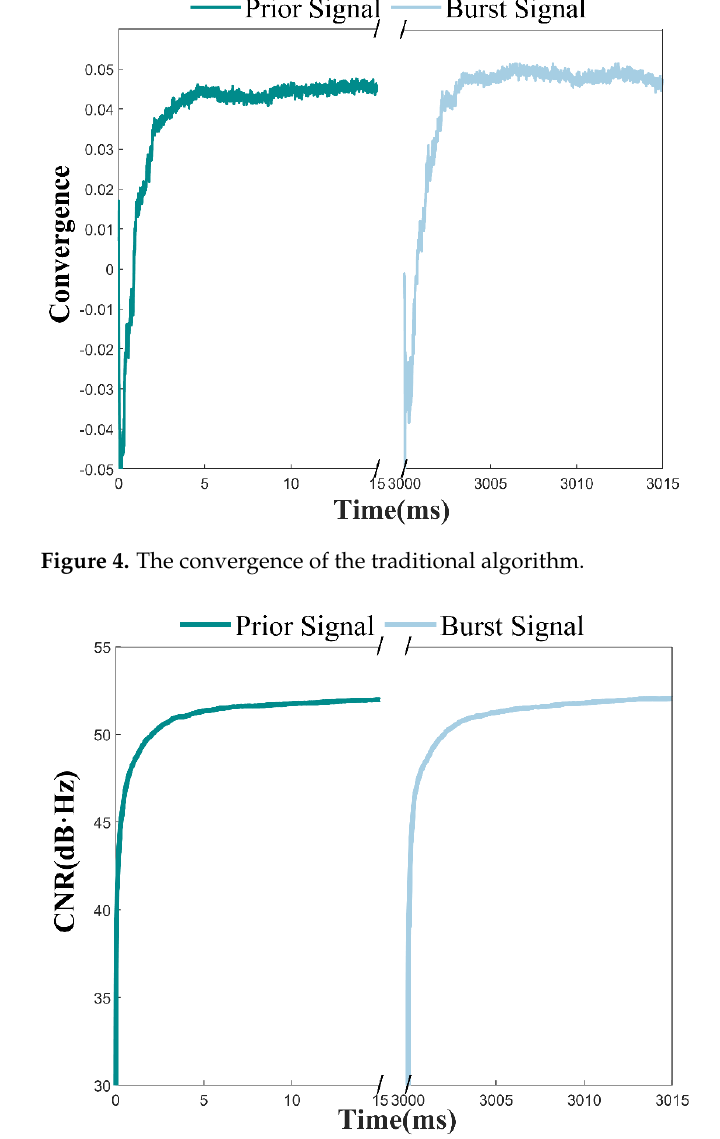
Figure 5. The estimated CNR of the traditional algorithm.